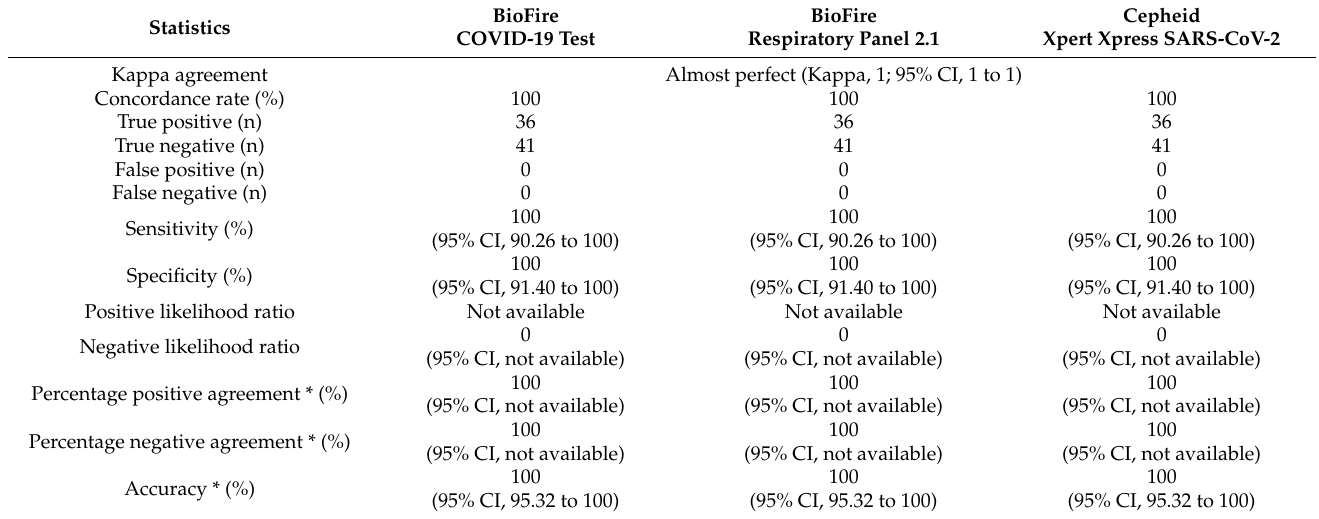
Table 2. Diagnostic performance statistics of BioFire COVID-19 Test, BioFire Respiratory Panel 2.1, and Cepheid Xpert Xpress SARS-CoV-2 assays for sample-to-answer detection in 77 clinical